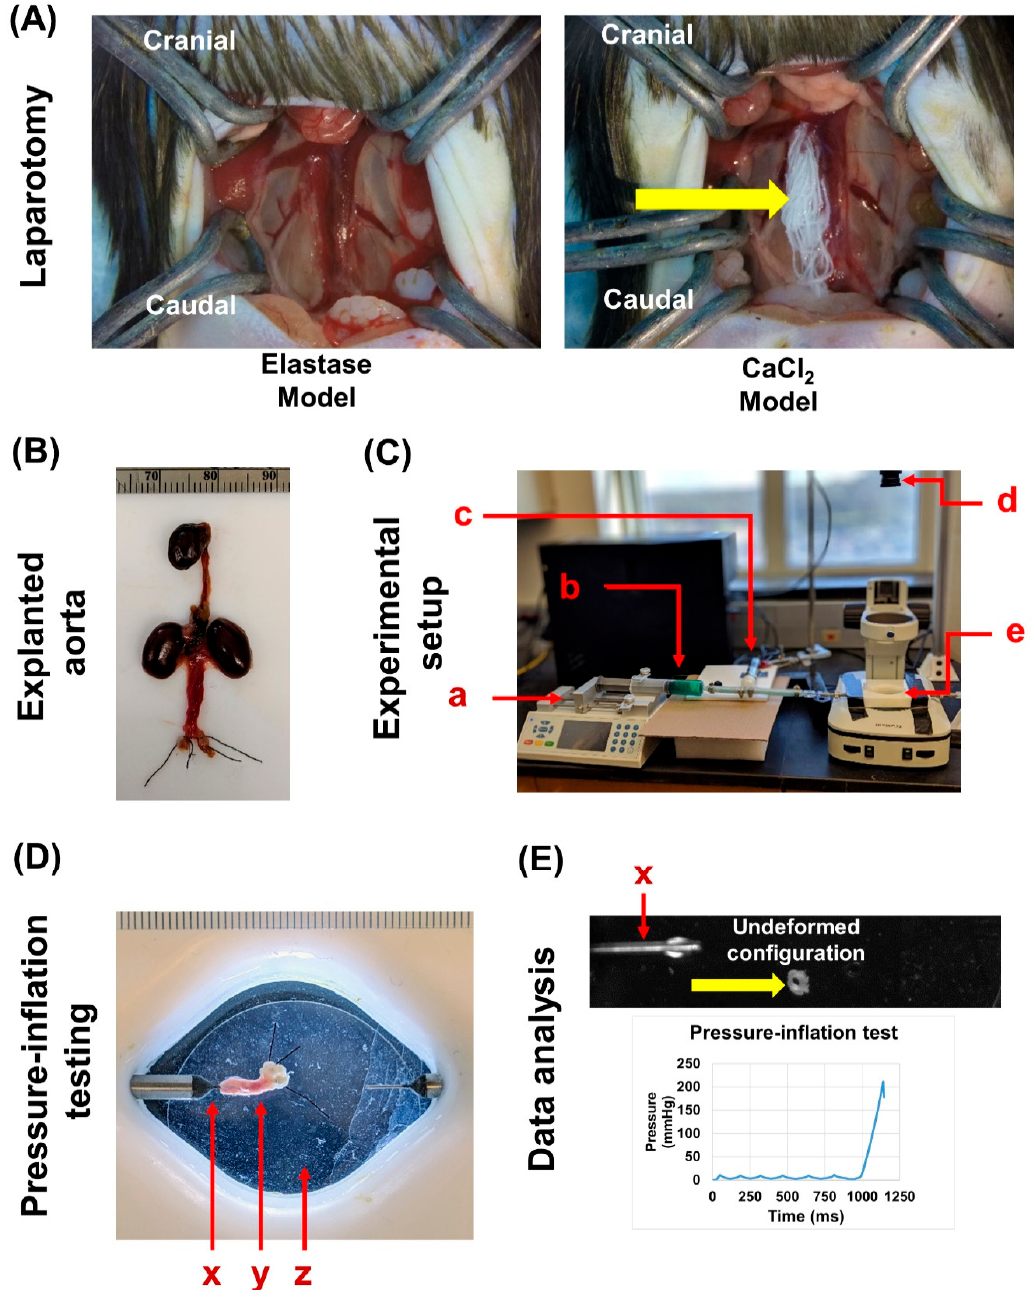
Figure 2. Biomechanical testing of abdominal aorta specimens. ( A ) Frontal views of the abdominal cavity of the elastase and CaCl 2 models after laparotomy, respectively. The yellow arrow on the CaCl 2 model indicates the CaCl 2 -soaked gauze that was applied to the periadventitial surface of the exposed abdominal aorta to initiate aortic injury. ( B ) Exemplary image of an explanted intact aorta along with the iliac arteries securely tied with sutures. ( C ) Experimental setup for pressure-inflation testing. The components are as follows: (a) Chemyx syringe pump, (b) syringe filled with PBS + food dye (for leak detection), (c) Omega pressure transducer with a range of 5 psi, (d) Basler high-resolution monochromatic camera for capturing specimen images, and (e) organ bath with 0.5 mm diameter cannula (World Precision Instruments). ( D ) Top view (as seen from the Basler camera) of the infrarenal aortic specimen (y), loaded onto the cannula (x), and placed in the saline filled organ bath (z). ( E ) To measure the thickness of the specimens, aortic rings were dissected (yellow arrow) and placed upright in the organ bath; the cannula (x) was utilized as a reference for image resolution, and the undeformed configuration (transverse view) was captured using the same camera setup. Using a custom LabVIEW script, incremental pressure changes with their accompanied time points were recorded for each